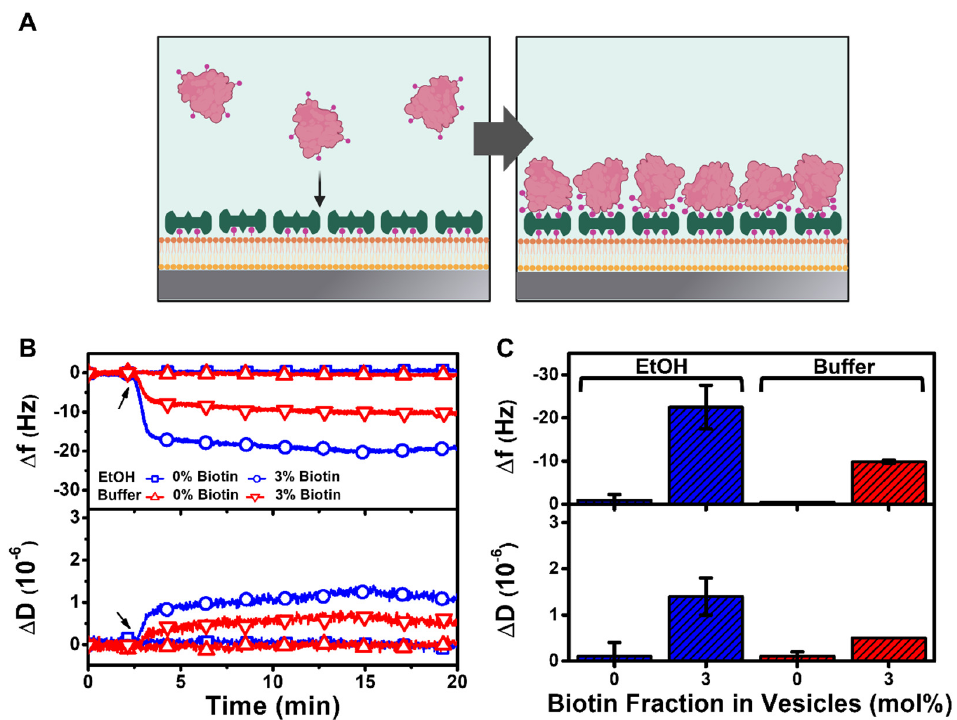
Figure 6. QCM-D tracking of biotinylated BSA protein attachment to a streptavidin-functionalized HLB platform. ( A ) Schematic illustration of biotinylated BSA attachment to a streptavidin-functionalized HLB platform. The platforms were fabricated using DOCP-functionalized TiO 2 surfaces that had been prepared using ethanol (EtOH) or buffer deposition protocols. ( B ) Time-resolved ∆ f and ∆ D signals are reported for biotinylated BSA attachment to streptavidin-functionalized HLB plat- forms containing 0 or 3 mol% biotinylated lipids. The arrow indicates the start of biotinylated BSA addition. ( C ) Summary of final ∆ f and ∆ D shifts for biotinylated BSA attachment corresponding to data in panel ( A ). The data are presented as the mean ± standard deviation from n = 3 runs.